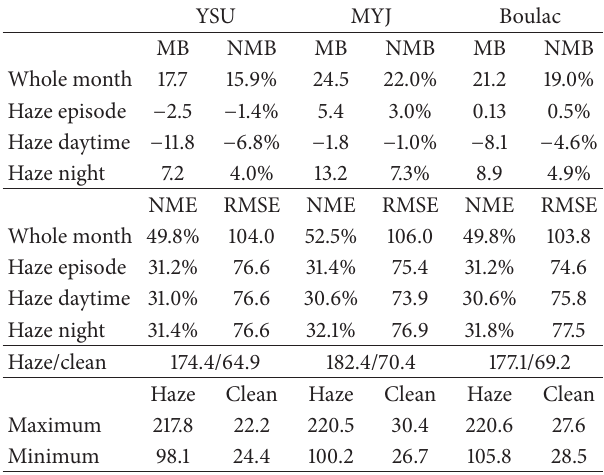
Table 2: Comparisons of statistical indicators of PM 2.5 .